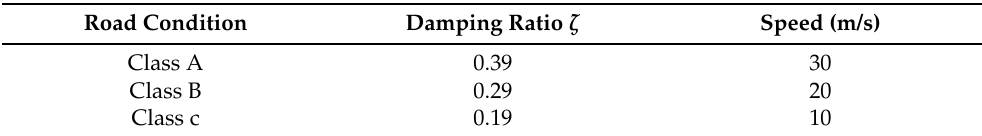
Table 1. Vehicle speed and damping ratio under different road conditions.